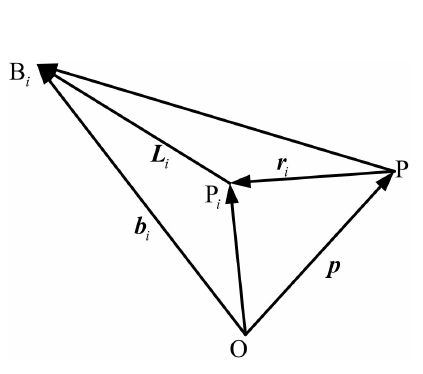
Figure 4. Single-cable vector